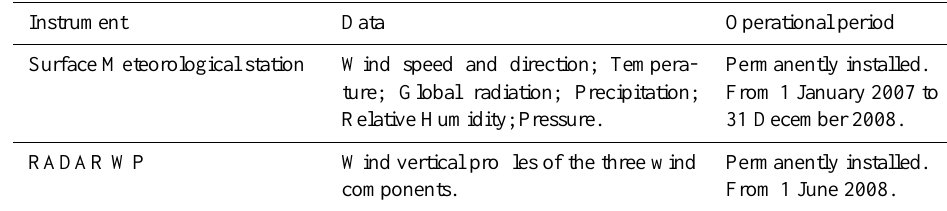
Table 1. Instruments, parameters measured and working periods. Instrument